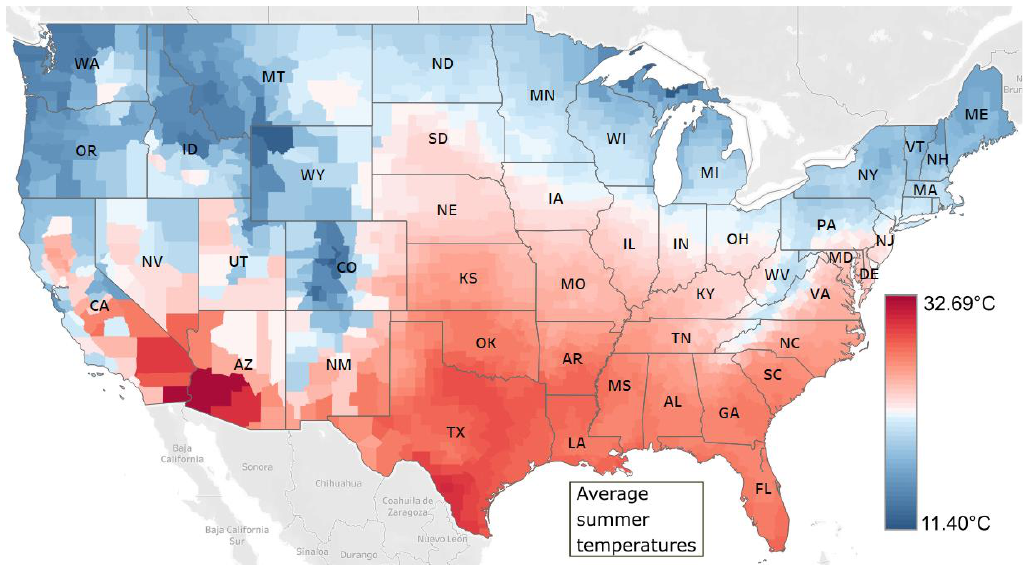
Figure 3. Average summer temperatures in °C for every county in the continental United States.